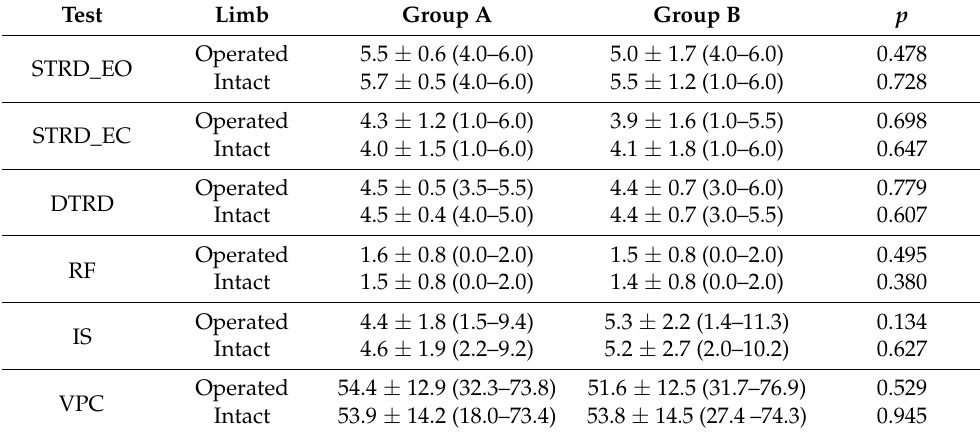
Table 5. The visual proprioceptive control results. Values are presented as median ± standard deviation. The minimum and maximum values are given in brackets. p values are indicated. STRD_EO—deviations from the resultant of static Riva test (STR) mean axes, eyes open; STRD_EC— deviations from the resultant of STR mean axes, eyes closed; RF—risk fall; DTRD—deviations from the resultant of dynamic Riva test (DTR) mean axes; IS—instability of the human-platform system; and VPC—visual-proprioceptive control